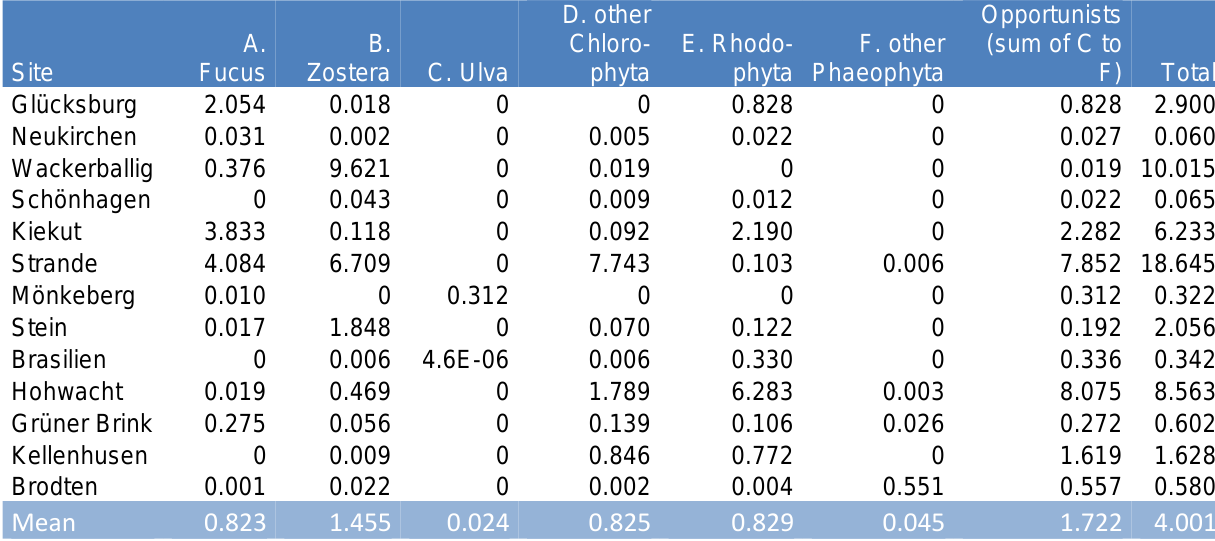
Table S1A: Dry matter of different macrophytes in beach wrack sampled in August 2012, related to length of beach line [kg m -1 ]